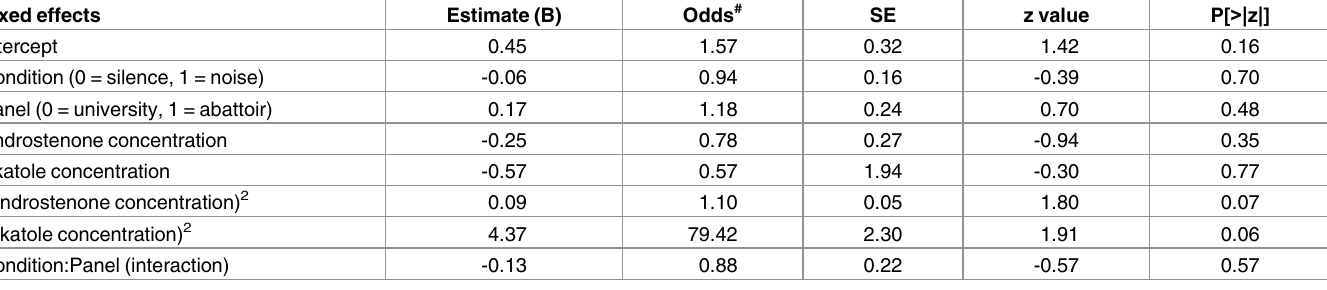
Table 1. Parameterestimatesof the logistic mixed model using the agreement * between sensory and chemical analysis as response variable for the abattoir and the university